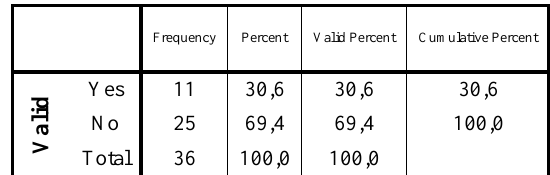
Table 9: Opinion of Accounting Professionals about